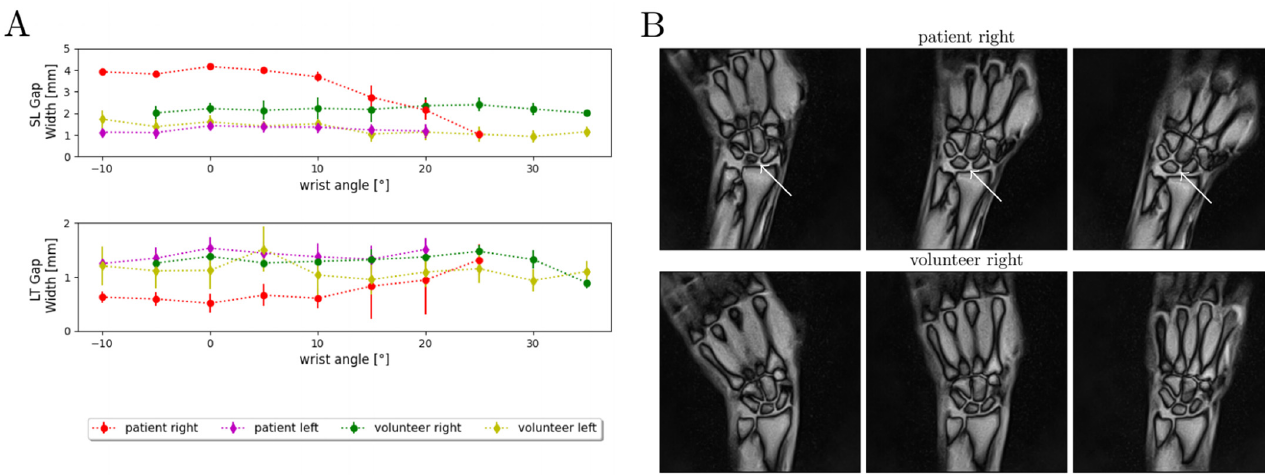
Figure 7. Quantitative and qualitative changes in carpal configurations in a patient with a partial scapholunate ligament rupture and a gender- and size-matched healthy volunteer during active radioulnar movement. ( A ) SL and LT gap widths are given as a function of wrist angle across the range-of-motion. The gap widths are indicated as means (dots) and standard deviations (whiskers). A total of 300 MR images per wrist were analyzed and quantified by our framework. Indicated are the measured SL and LT gap widths of the wrist-injured patient (partial SL ligament rupture, “patient right”, red), the contralateral wrist (“patient left”, purple), and the corresponding wrists of the matched and healthy volunteer (“volunteer right”, green; “volunteer left”, yellow). For the sake of visualization, the wrist angles are grouped at intervals of 5°. ( B ) Three exemplary MR images are shown for the patient and the volunteer at various positions throughout the active radioulnar movement range. The increased dehiscence of the SL gap of the injured wrist (white arrows) is particularly obvious in the neutral position and ulnar abduction and at the proximal portion of the SL gap.